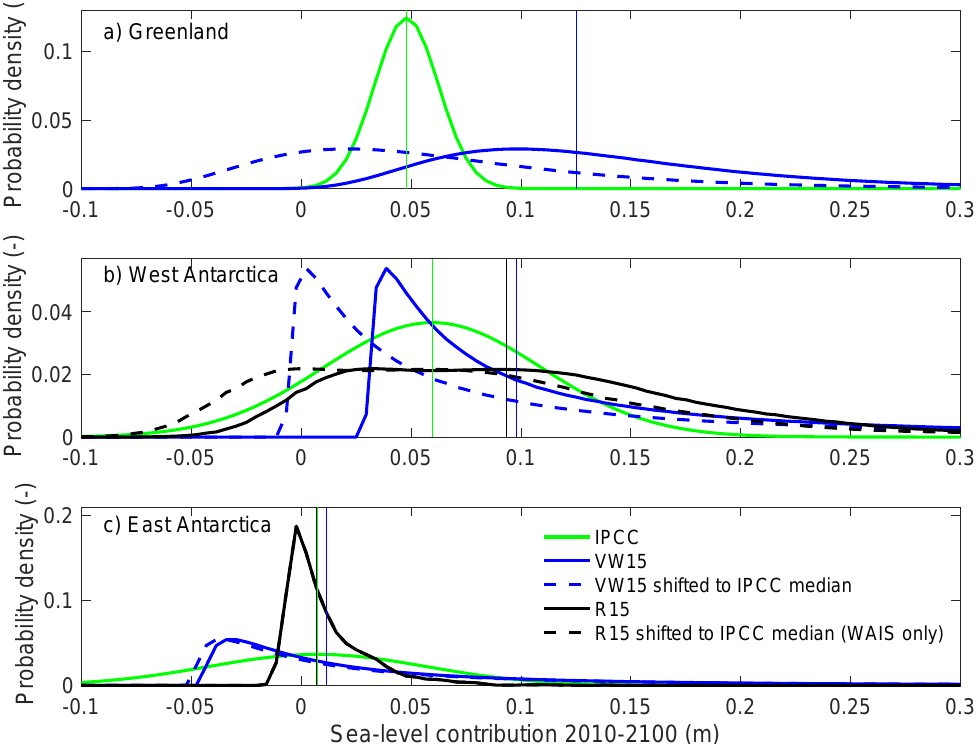
Figure 1. The three scenarios for ice sheet dynamics contributions to sea-level rise used in this study, for ( a ) Greenland, ( b ) West Antarctica and ( c ) East Antarctica (cumulative m sea-level change between 2010–2100). Original uncertainty distributions in solid lines, medians in vertical lines, shifted uncertainty distributions (where all medians match the IPCC medians) in dashed